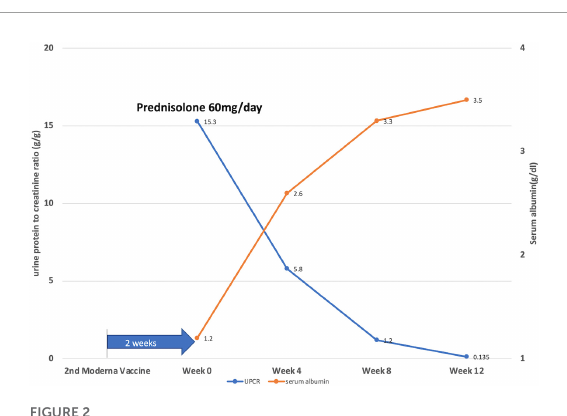
FIGURE2 Illustration of the disease course by showing daily protein loss and serum albumin levels of the patient after 2 weeks of the second dose of the Moderna COVID-19 vaccine. Week 0: start prednisolone treatment (1